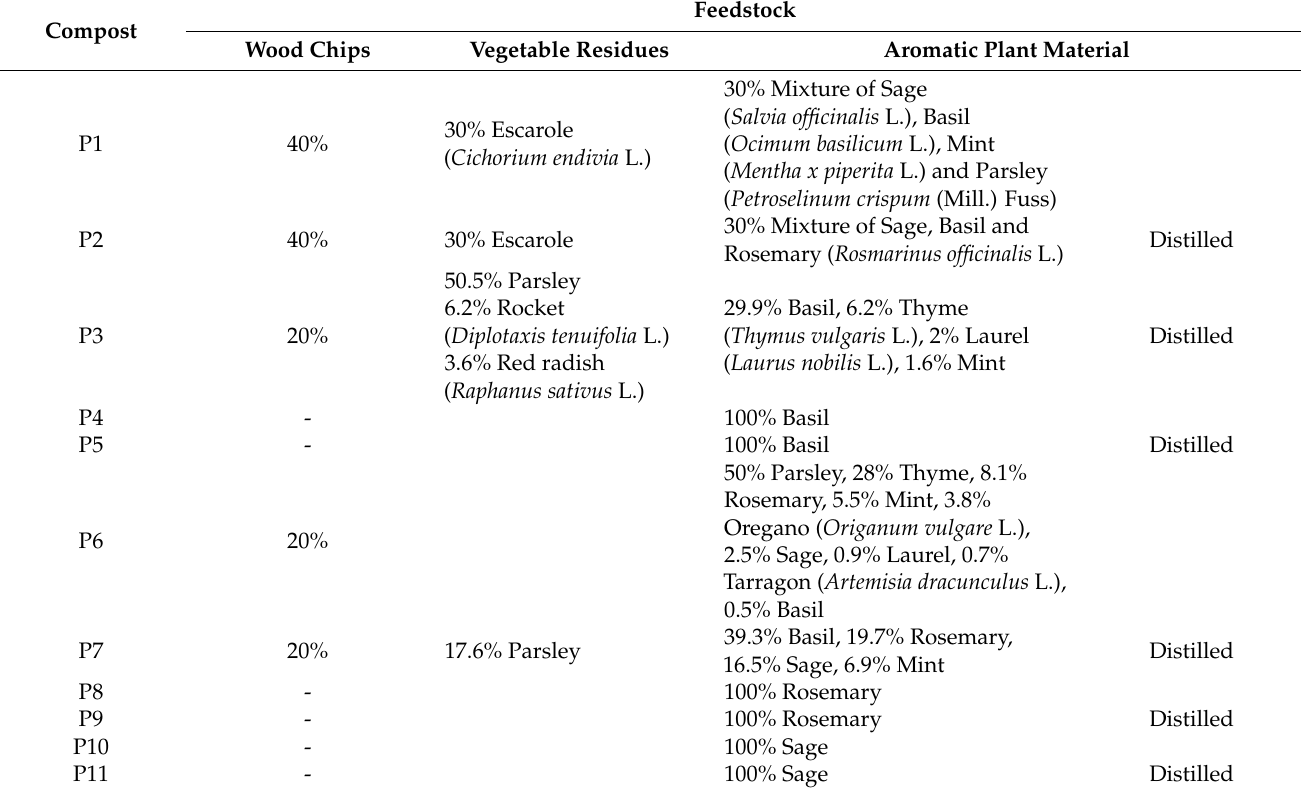
Table 2. Main compost feedstock used to produce P1–P11